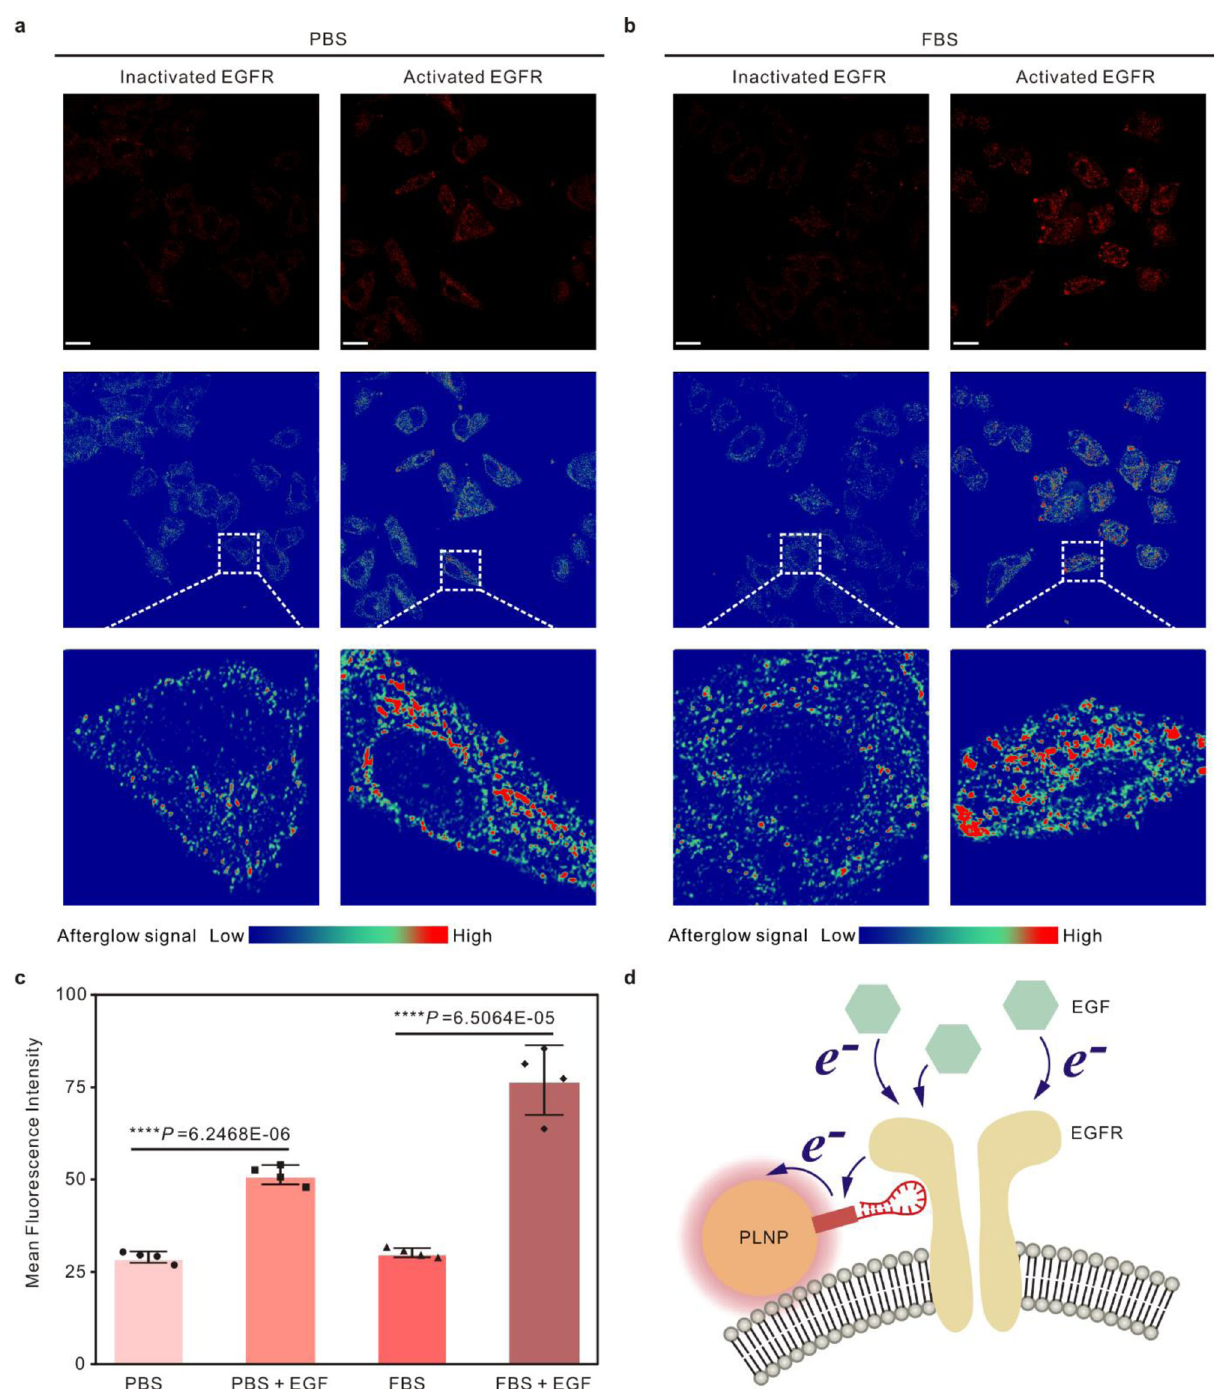
Fig. 4 EGFR signaling pathway-related electron transfer imaging in living cells. All cells were incubated with ETTE nanoprobes and DAPI for imaging (Supplementary Fig. 25). Afterglow images and corresponding pseudo-color images of ETTE nanoprobes from A549 cells incubated without or with EGF in PBS ( a ) and in 10% fetal bovine serum (FBS) culture medium ( b ). Higher intensities re fl ect higher EGFR signaling activity. Color scale ( Δ F / F 0 ): 0 – 1.5. Scale bar, 20 μ m. The laser of 635 nm and 365 nm were used as the excitation sources, afterglow signal from the ETTE probe was obtained at 1.0 s after excitation. The imaging experiments were repeated independently three times and similar results were obtained. c The bar graph shows the relative afterglow intensities of ETTE nanoprobes. Data are presented as the mean values ± s.d.; unpaired two-tailed Student ’ s t -test; n = 4